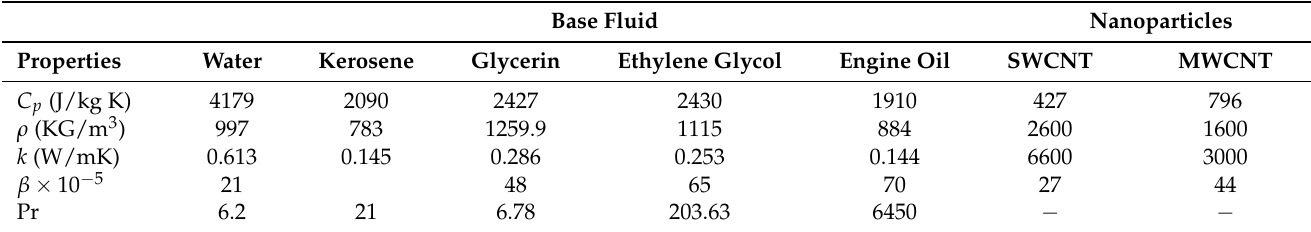
Table 1. Thermophysical properties of fluid and nanoparticles (for reference see Sheikholeslami et al. [5]). Base